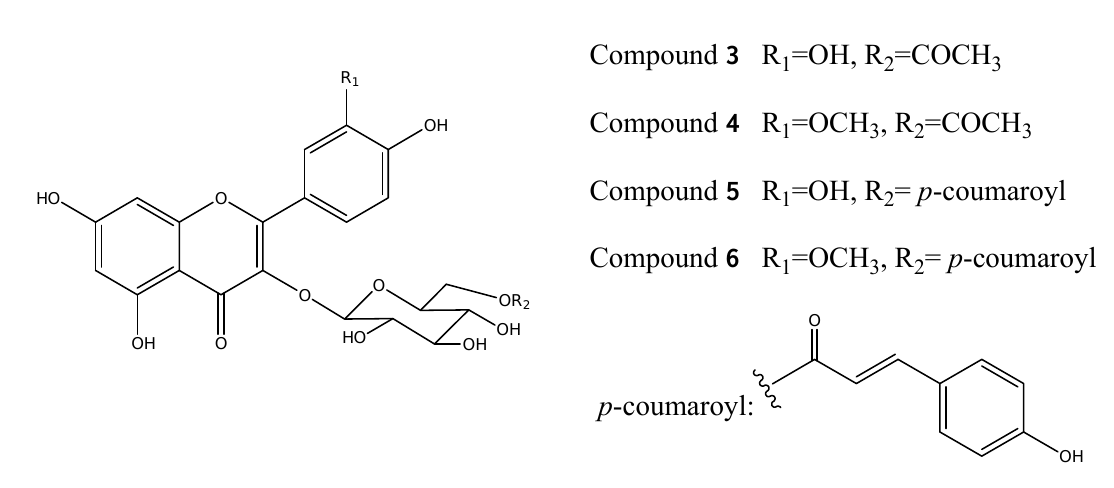
Figure 2. The structures of compounds 3-6